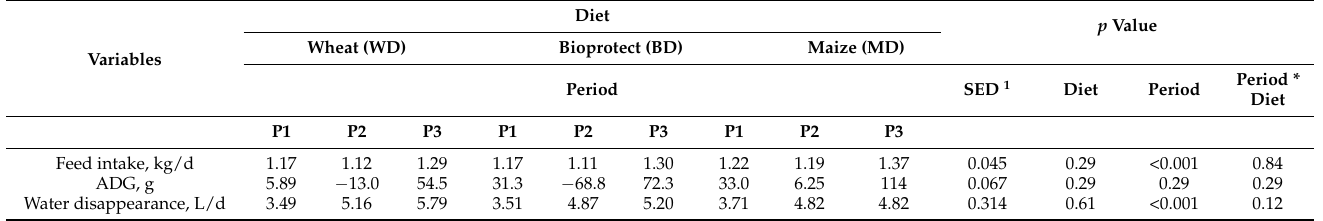
Table 2. Feed intake, average daily gain, and water disappearance of lambs fed on wheat, Bioprotect treated wheat, and maize-based diets under different periods.